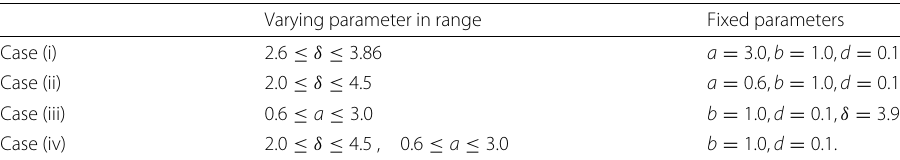
Table 1 Parameter values Varying parameter in range Fixed